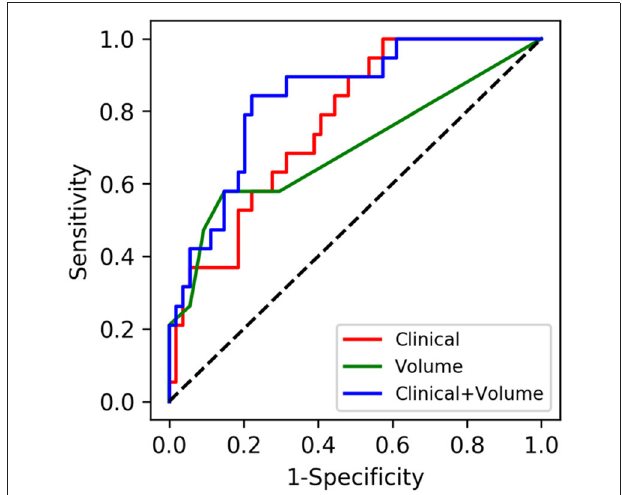
FIGURE 5 | Performances of machine learning models for the prediction of progression to severe stroke: receiver operating characteristic (ROC) curves of three feature sets when using the random forest